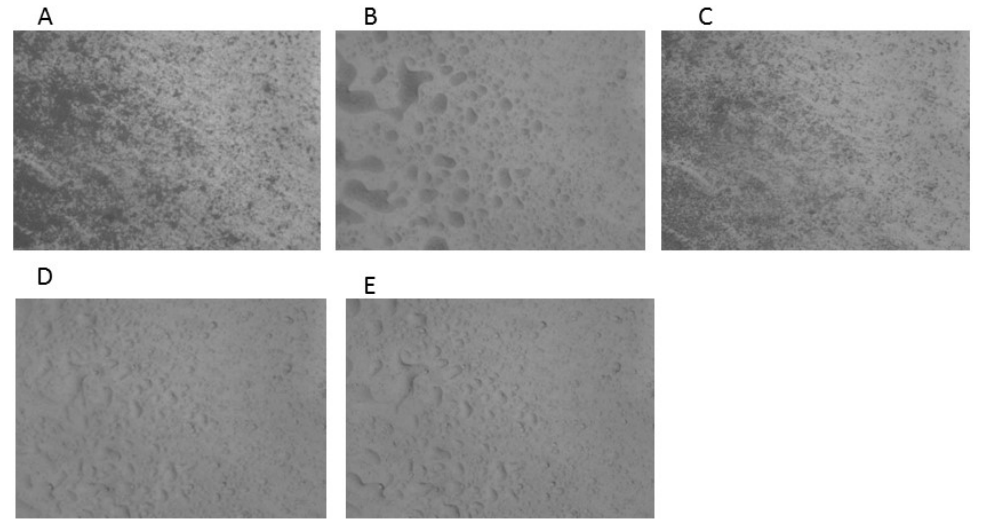
Figure 2. HSM micrographs for ABZ at di ff erent temperatures: ( A )—ABZ at 25 ◦ C; ( B )—ABZ at 25 ◦ C—back cooled product; ( C )—ABZ at 195 ◦ C—melting starts; ( D )—ABZ at 197 ◦ C—melted; ( E )—ABZ at 200 ◦ C—melted. The magnification in the photographs was 59.7 ×